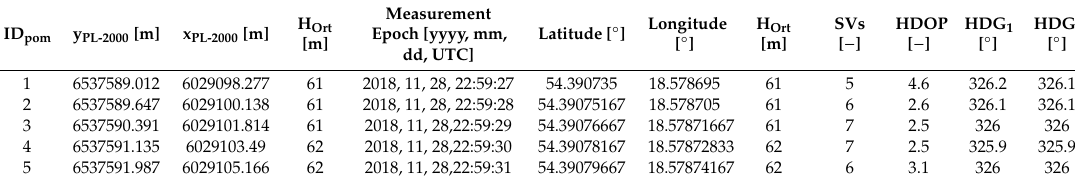
Table 2. Fragment of the input file containing satellite compass observations.